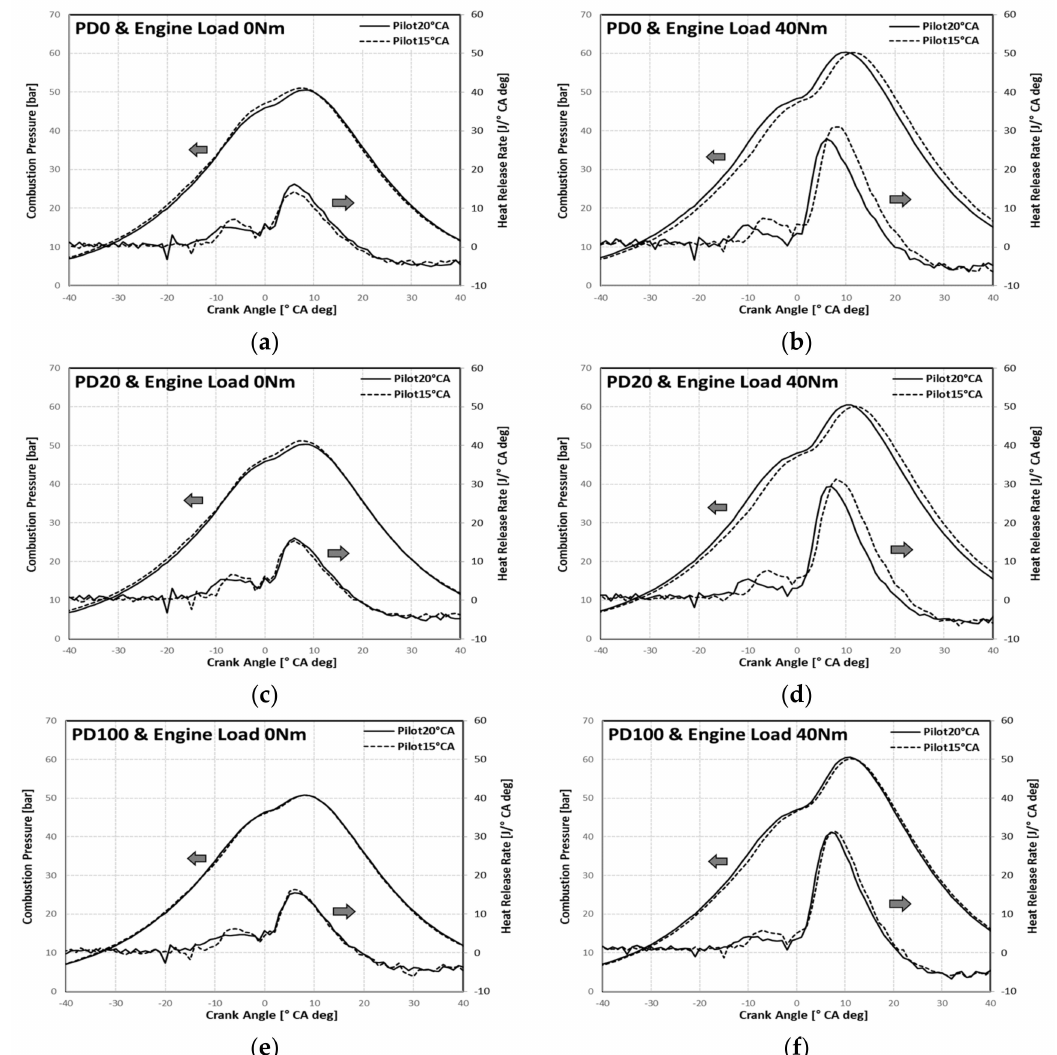
Figure 4. Combustion pressure and heat release rate by pilot injection timings. ( a ) PD0 and engine load 0 Nm, ( b ) PD0 and engine load 40 Nm, ( c ) PD20 and engine load 0 Nm, ( d ) PD20 and engine load 40 Nm, ( e ) PD100 and engine load 0 Nm and ( f ) PD100 and engine load 40